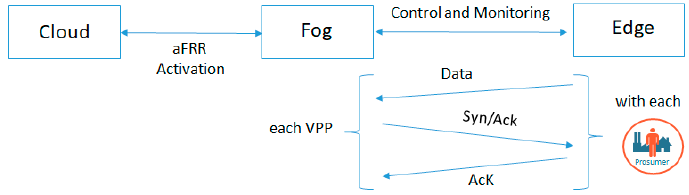
Figure 13. Messages exchange in our fog based approach.